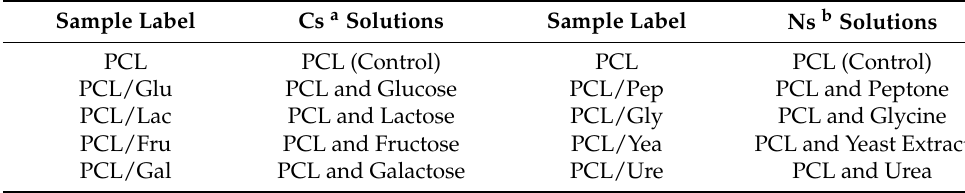
Table 1. PCL/Cs and PCL/Ns fiber and film